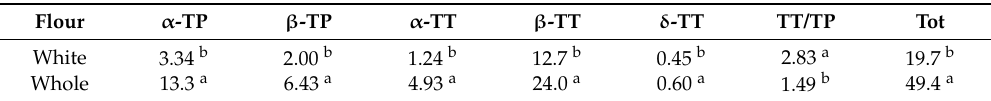
Table 2. Mean values (mg kg − 1 ) of various tocols depending on flour type (white versus whole meal flour).